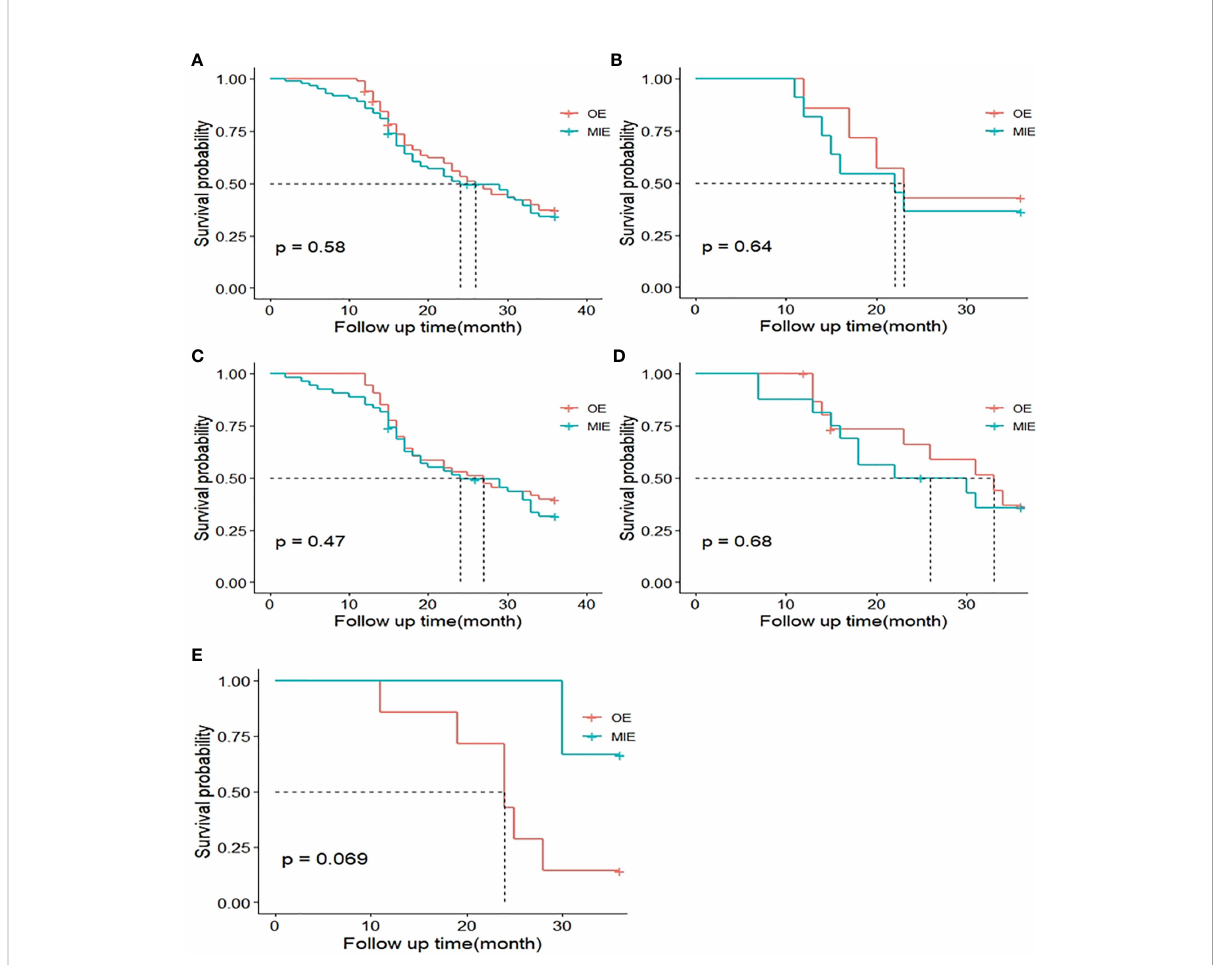
FIGURE 4 Kaplan – Meier curves of 3-year disease-free survival (DFS) between both groups. (A) DFS curves of the MIE and OE groups after matching. (B) DFS curves of patients with the percentage of estimated forced expiratory volume in the fi rst second (%FEV1) 50% – 60%. (C) DFS curves of patients with %FEV1 60% – 70%. (D) DFS curves of patients with %FEV1 70% – 80%. (E) DFS curves of patients with %FEV1